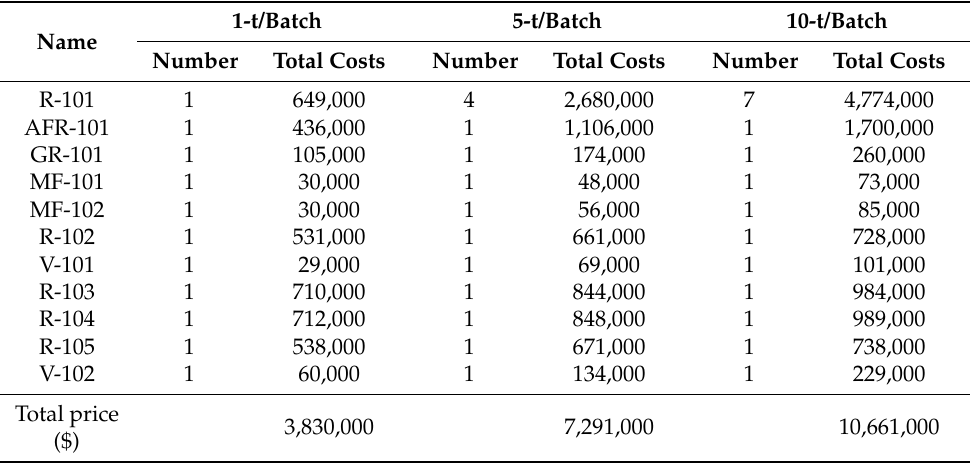
Table 4. The total equipment cost per batch for different production scales of Ti powder in